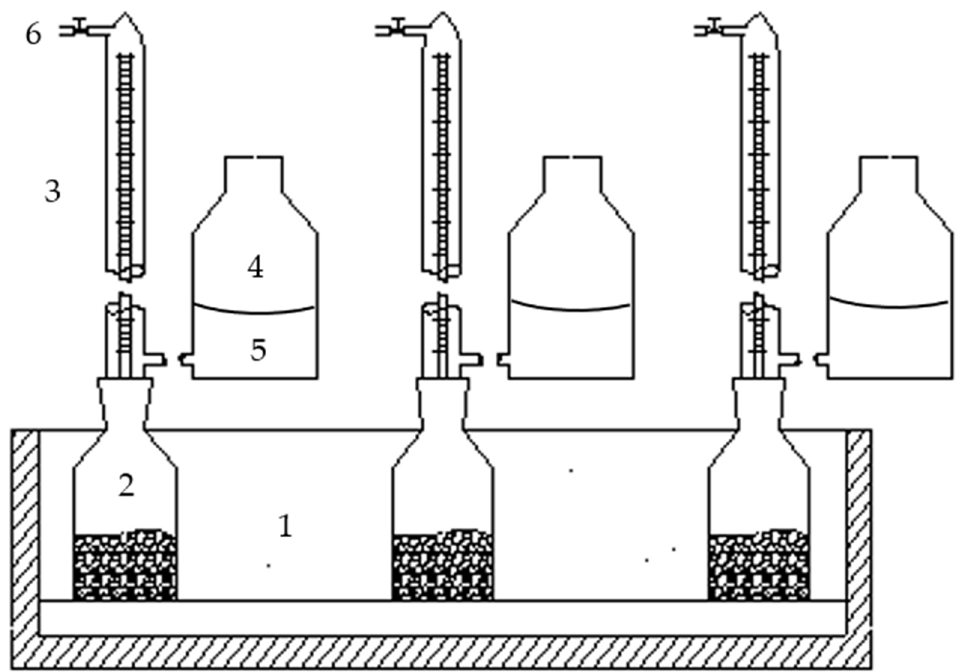
Figure 1. Schematic diagram of batch tests: 1 — water bath, 2 — reactor, 3 — burette/eudiometer, 4 — bottle, 5 — barrier liquid, 6 — valve .